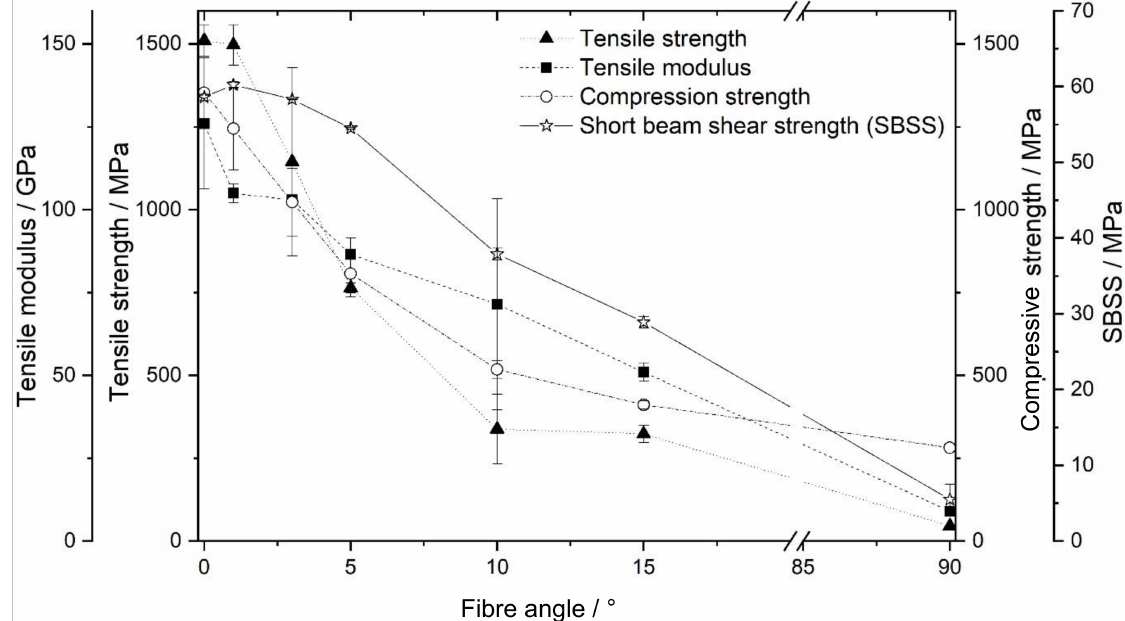
Figure 3. Mechanical performance of CFRP samples with an out-of-plane fibre orientation. (Given strengths are calculated for the initial cross-sections of the samples and not the area of failure (see text).)